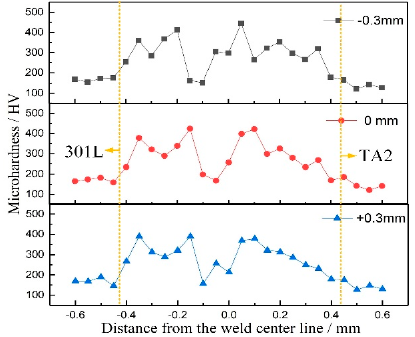
Figure 18. Microhardness distribution of 301L/Cu/TA2 welded joints.